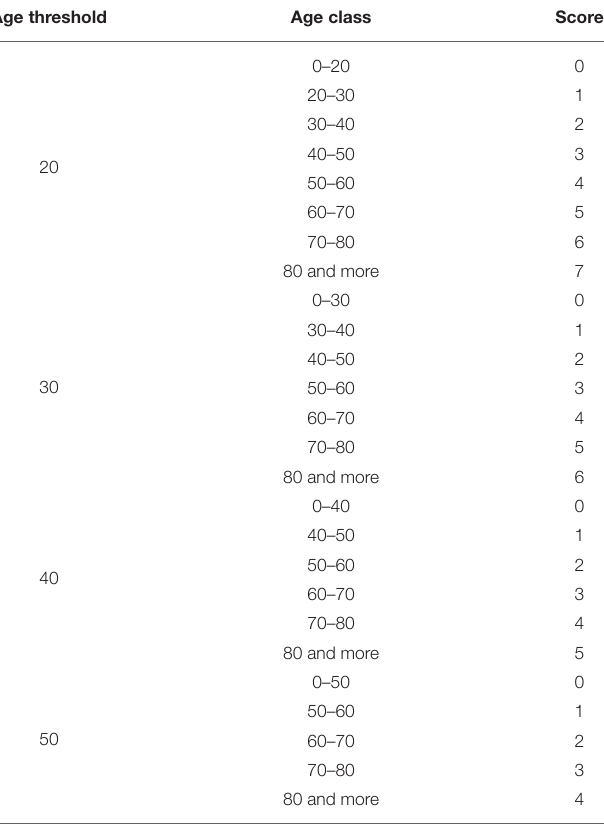
TABLE 1 | CCI score according to low-risk age